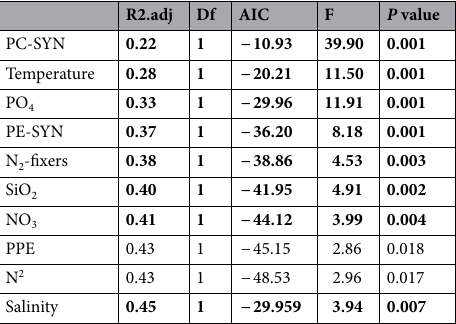
Table 2. P values included in the CCA model after stepwise analysis. Significant variables after the Holm correction are indicated in bold.